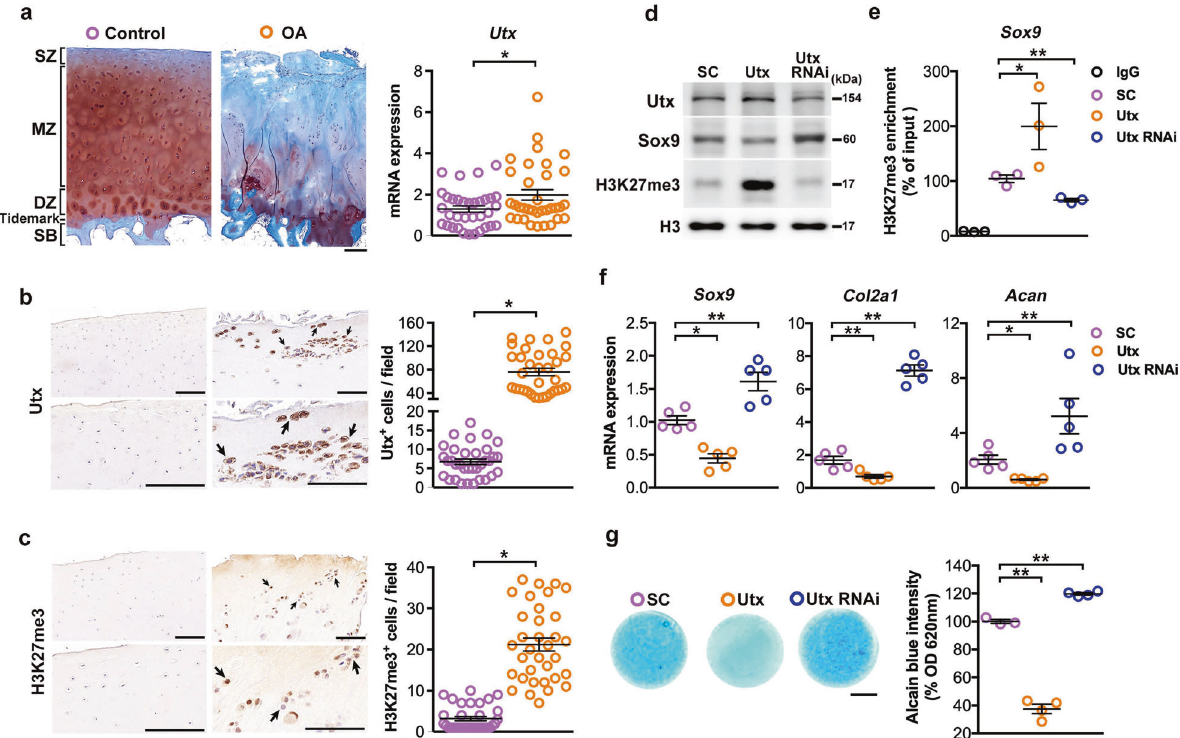
Fig. 1 UTX-dependent reduction in chondrocytic activities. Safranin-O staining of macroscopically normal human articular cartilage next to severely osteoarthritic tissue. Quanti fi cation of UTX mRNA abundance in both tissues revealed elevated UTX expression in gonarthrotic cartilage ( a ); scale bar, 200 μ m. Strong UTX ( b ) and H3K27me3 ( c ) immunostaining in osteoarthritic chondrocytes, next to quanti fi ed protein expression from 34 donors; scale bar, 20 μ m (low magni fi cation), 10 μ m (high magni fi cation). Forced UTX expression increased